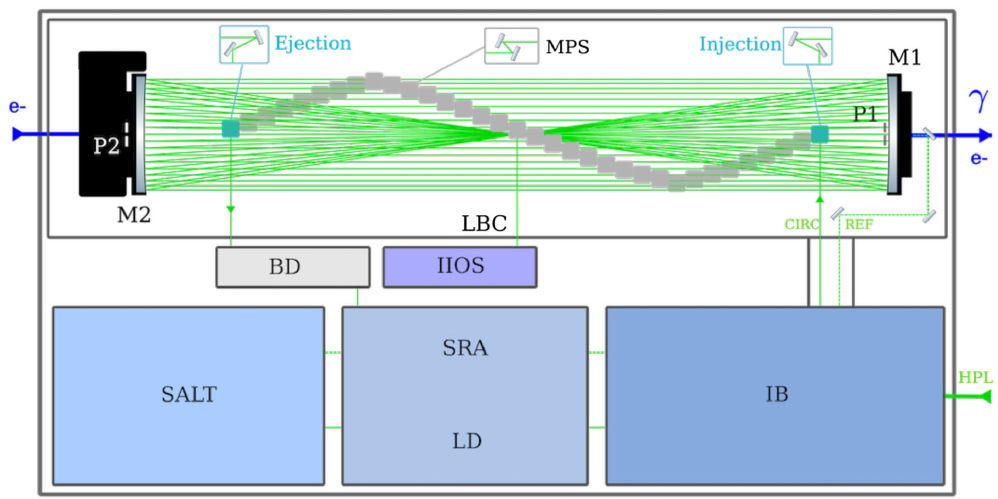
FIG. 2. Schematic top view of the interaction point module with its constituting part SALT: synchronization and alignment laser tool, SRA: self reference alignment, LD: laser diagnostic, IB: injection box, M1,M2: mirror parabolas, MPS: mirror pair system, injection and ejection mirror system. The input high power laser beam (HPL) and the direction of the electron beam ( e − ) are